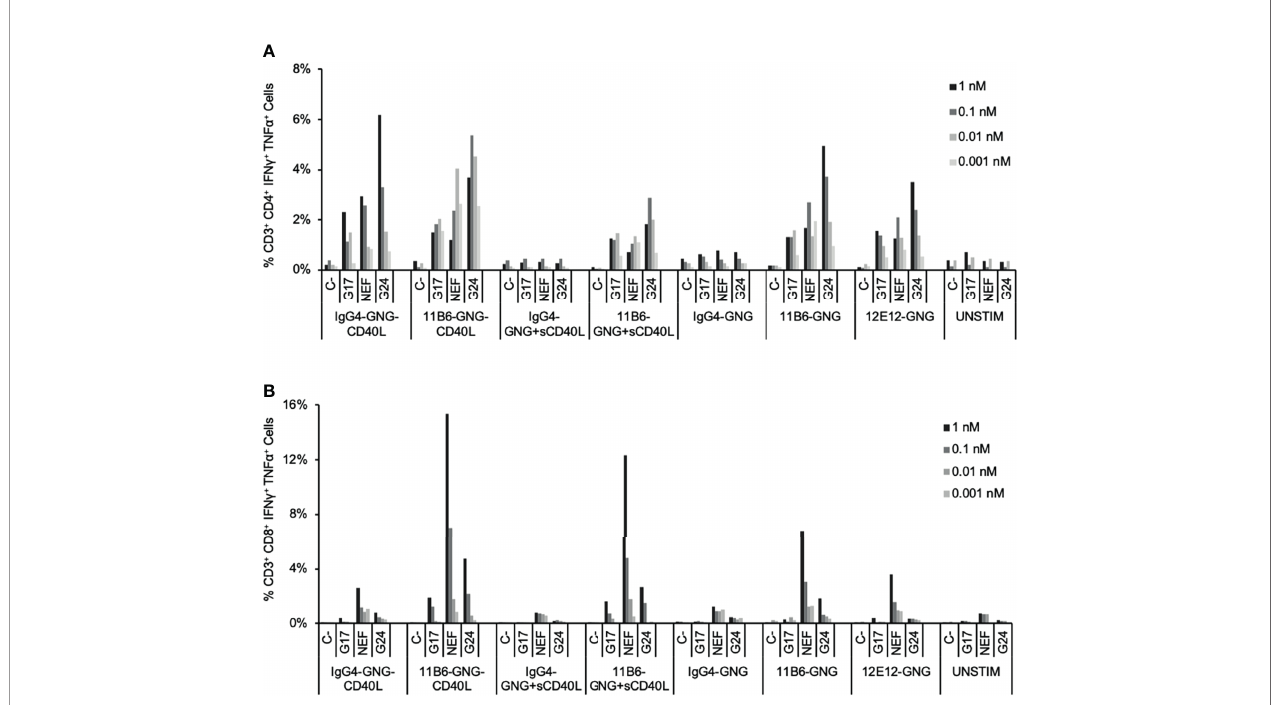
FIGURE 4 | Expansion by CD40-targeted GNG antigen of HIV-1-speci fi c T cells in HIV-1-infected donor PBMC cultures. HIV-1 + donor PBMCs were cultured with a dose range of anti-CD40-GNG fusion proteins with and without a low dose of sCD40L (100 ng/ml; 6 nM) and IL-2 for 9 days, followed by stimulation with peptides for pools HIV-1 Gag p17, Nef, and Gag p24 for 6 h, then analyzed by ICS. The data show the percentage at the end of the culture of antigen-speci fi c (A) CD4 + and (B) CD8 + T cells producing IFN g + TNF a in response to peptide stimulation. Similar data were obtained in a replicated experiment ( Supplemental Figure 2